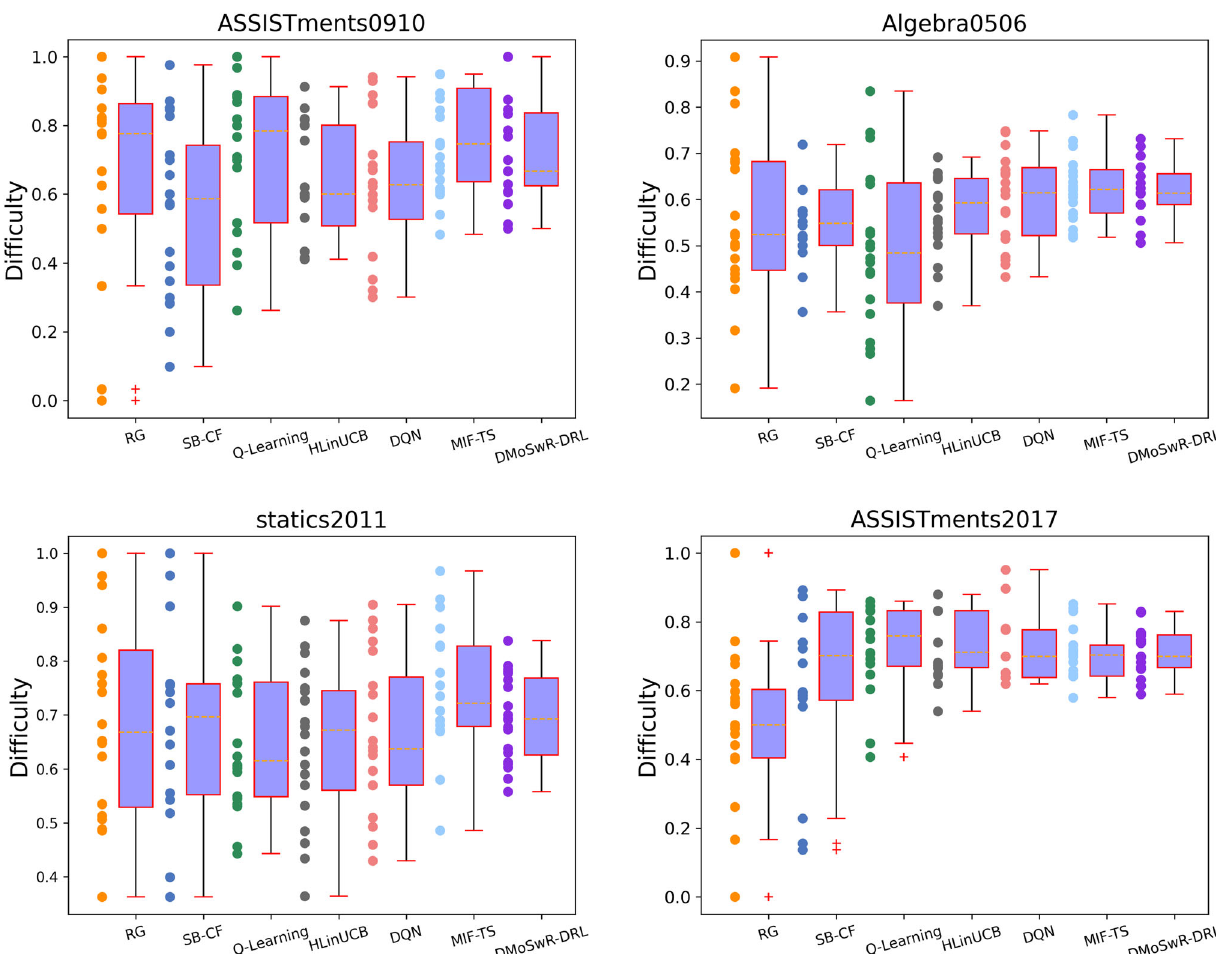
Fig. 7 Performance comparison of different models on four datasets in terms of